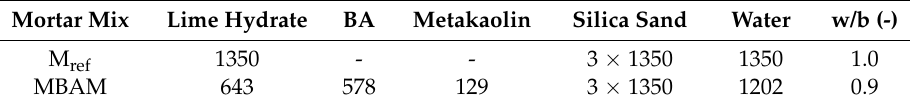
Table 1. Composition of studied mortars, mass (g). BA: biomass